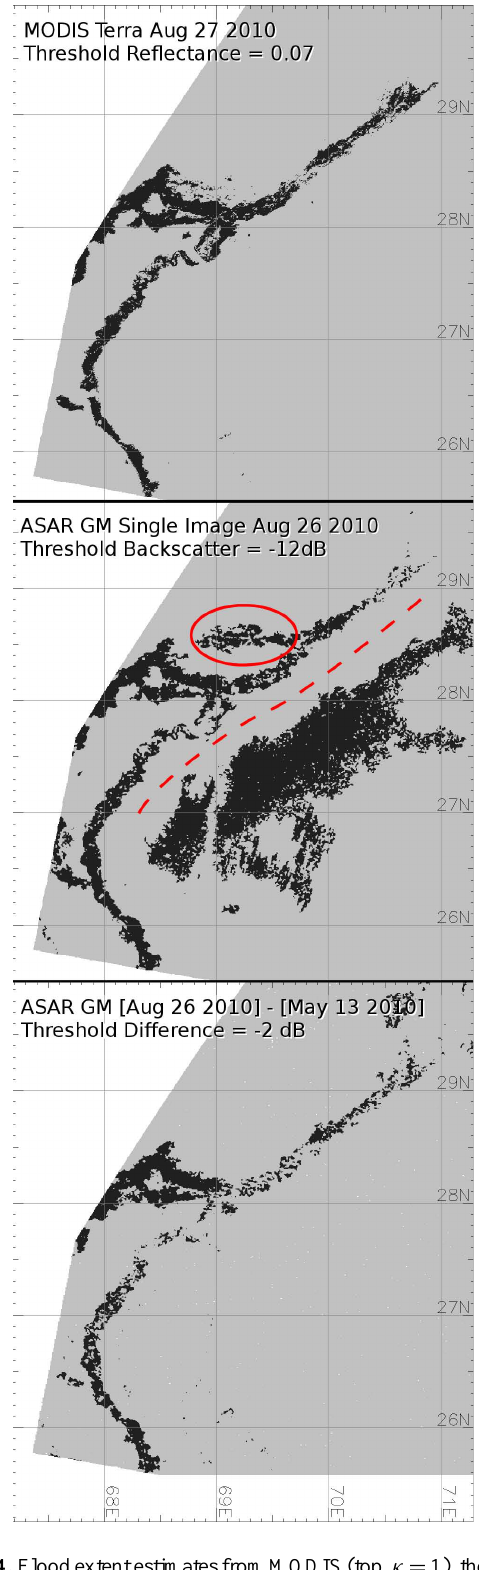
Fig. 14. Flood extent estimates from MODIS (top, κ = 1), the single contemporaneous GM image (centre, κ = 0 . 3) and the GM Differ- ence image (bottom, κ = 0 . 6), using optimised